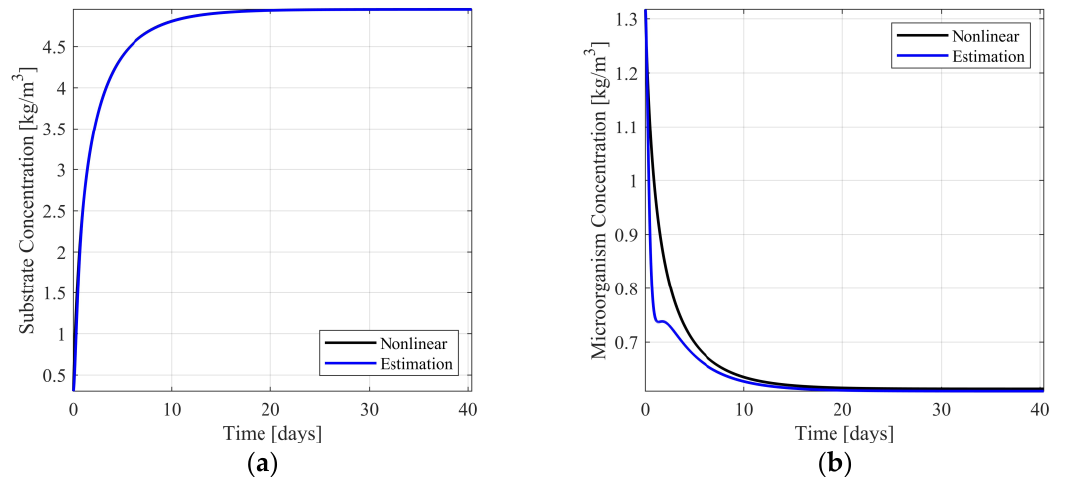
Figure 4. ( a ) Substrate concentration response/estimation; ( b ) Microorganism concentration re- sponse/estimation.